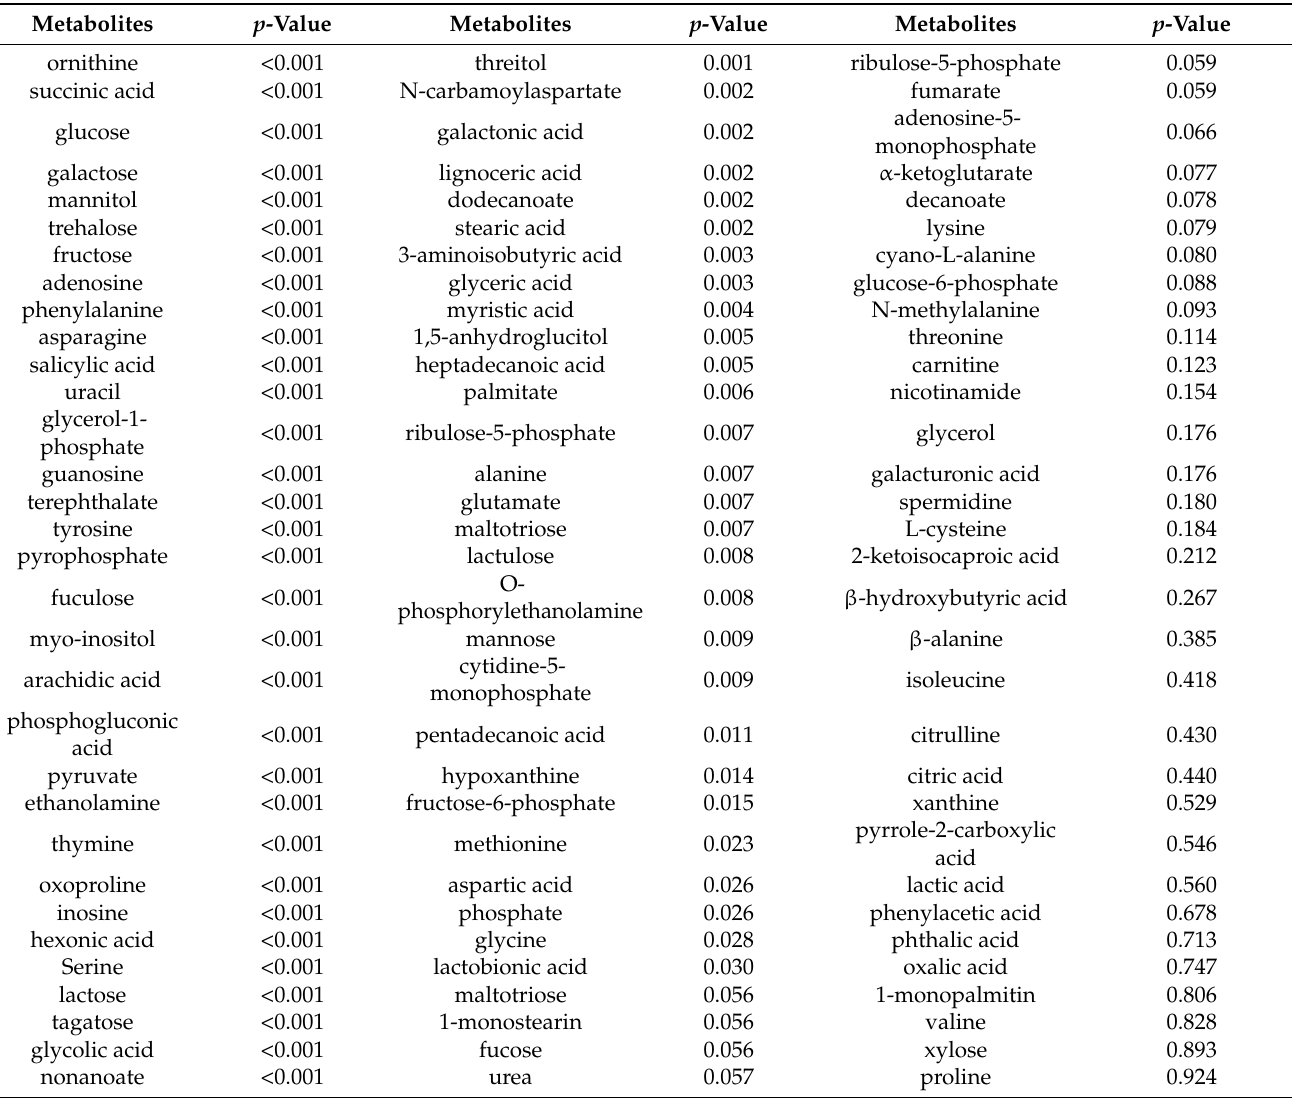
Table 2. Student’s t-test analysis of 96 metabolites from volar and non-volar skin